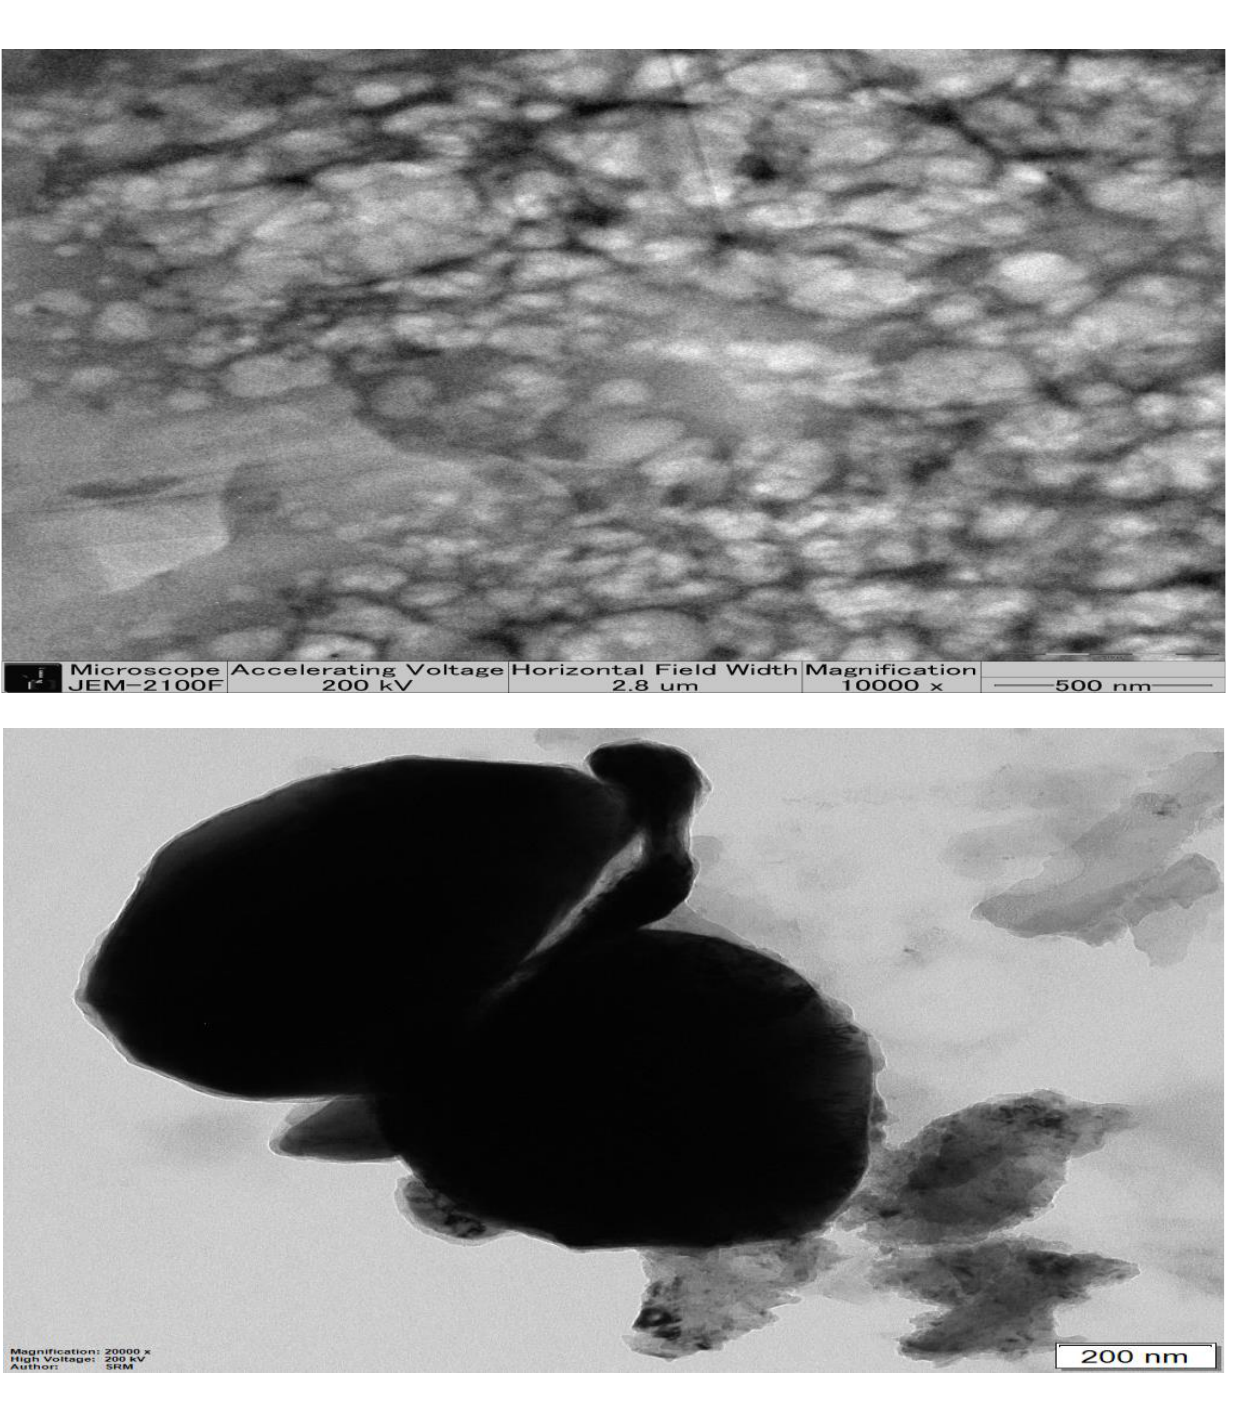
Figure 3. TEM images of optimized β - ST - loaded Cubosomes.